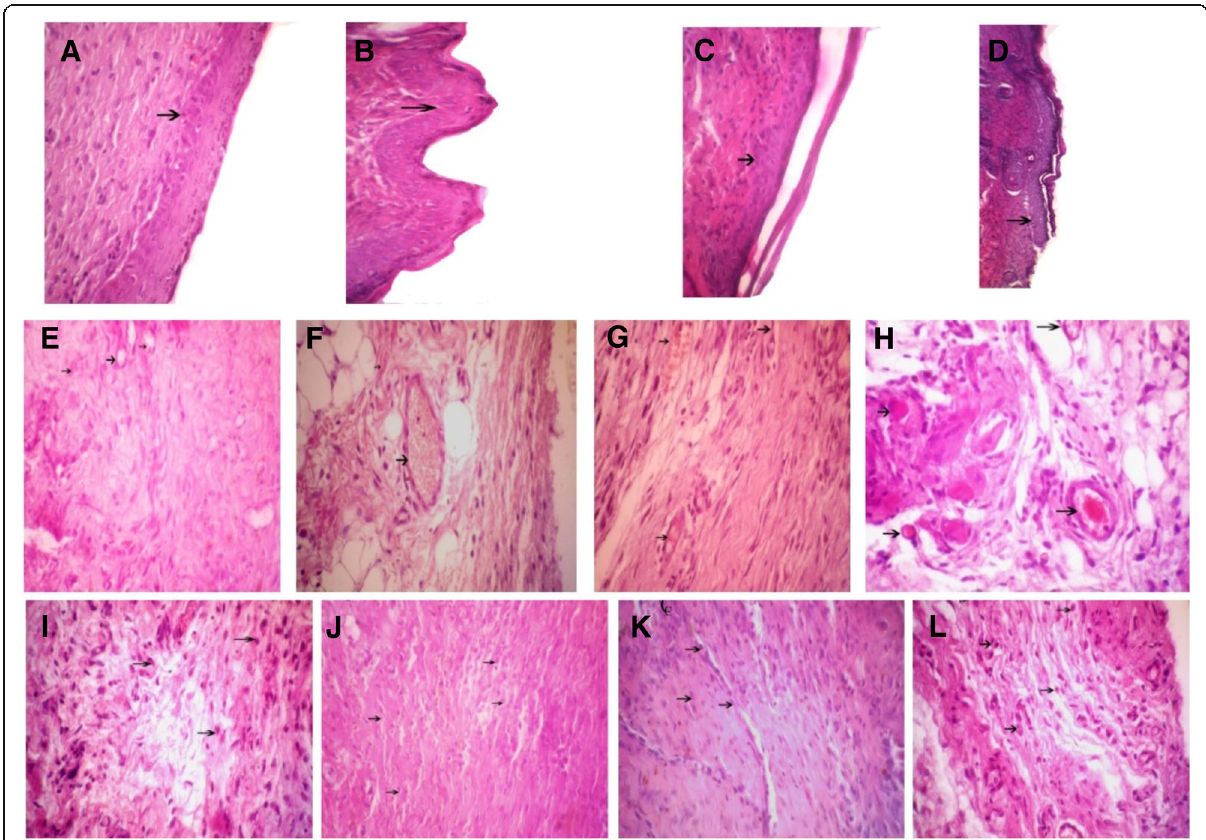
Fig. 7 Arrows show the wound epidermis regeneration ( a – d ), vascular formation ( e – h ), and granulation ( i – l ) on the 14th day. a , e , i Satureja khuzistanica -treated group. b , f , j Hydrogel alginate-treated group. c , g , k Satureja khuzistanica encapsulated in hydrogel alginate-treated group. d , h , l Control group. Hematoxylin and eosin stain (× 400). Arrows show the re-epithelialization with mild hyperplasia of epidermis and moderate hyperkeratosis ( a – d ) and immature granulation tissue ( i – l ) with emerging blood vessels (angiogenesis) shown in black arrows and fibroblasts and numerous